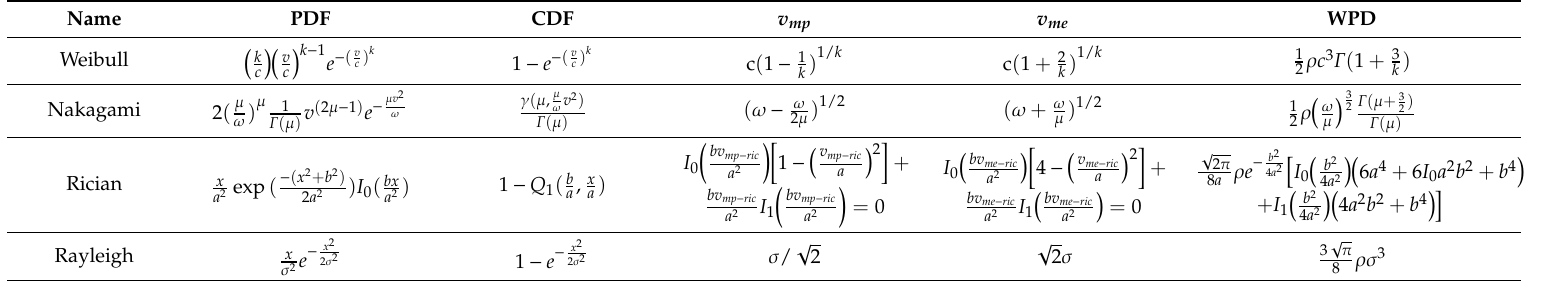
Table 10. PDFs, CDFs, and the parameters of wind potential assessment.